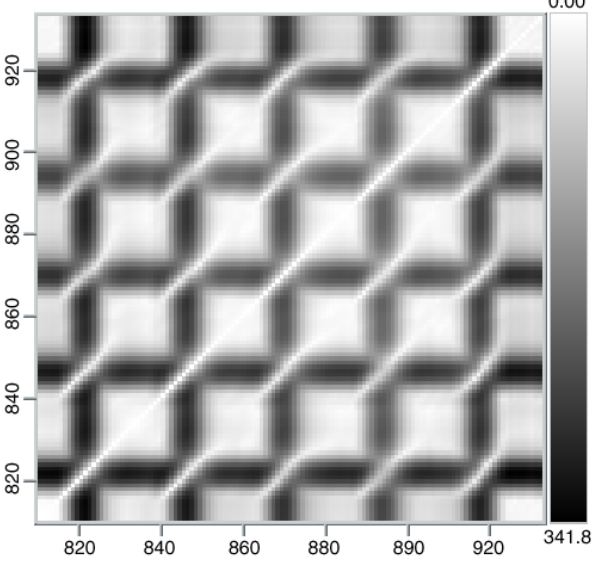
Fig. 6. The recurrence plot of the time series of